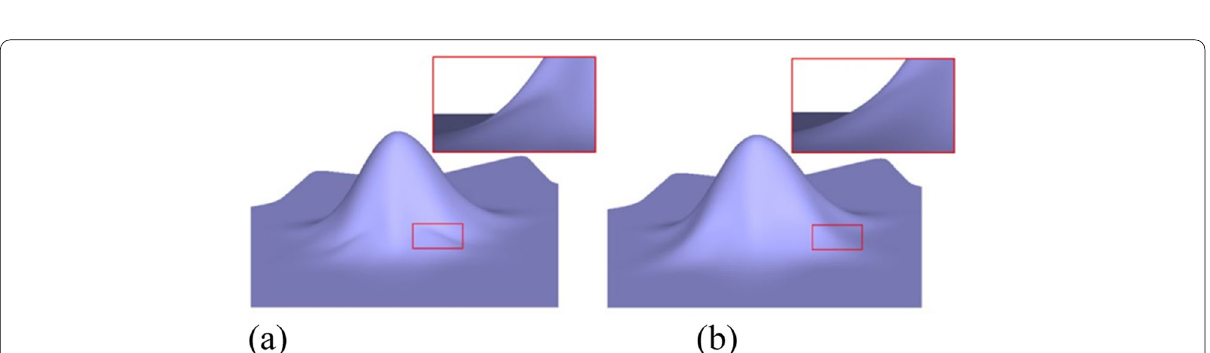
Fig. 8 Valence 7, with knot intervals of 100, 100, 1, 1, 100, 100, and 100. a Using the approach in ref. [7]; b Using the proposed